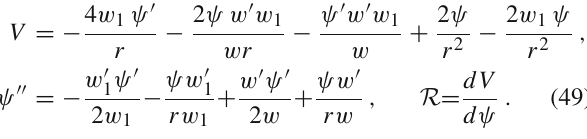
( a ) Quasilocal energy of the black hole solution (11) (b) Quasilocal energy of the black hole solution (15) Fig. 11 Schematic plot of the quasilocal energies of the two black holes (11) and (15) versus the dimensional parameter α and r + , respectively 4 w 1 ψ V = −